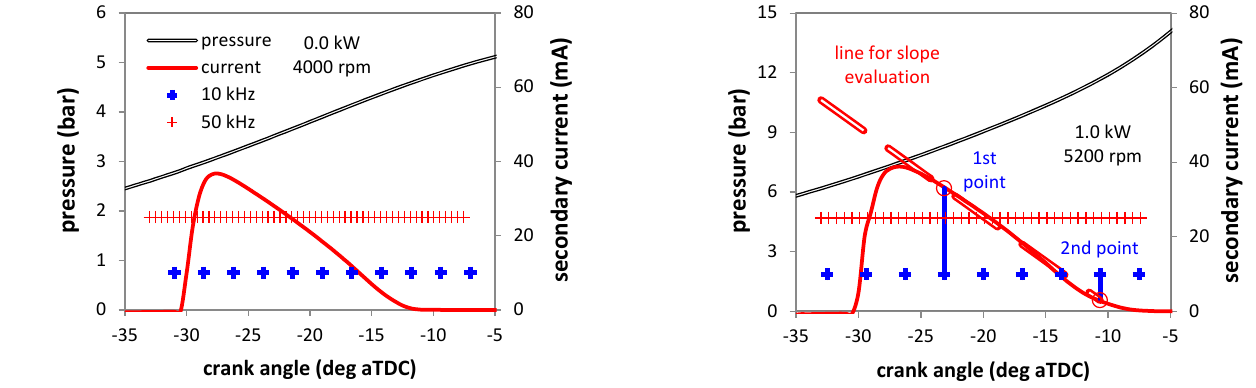
Figure 11. Illustration of sample rate effects on the points read during spark events.